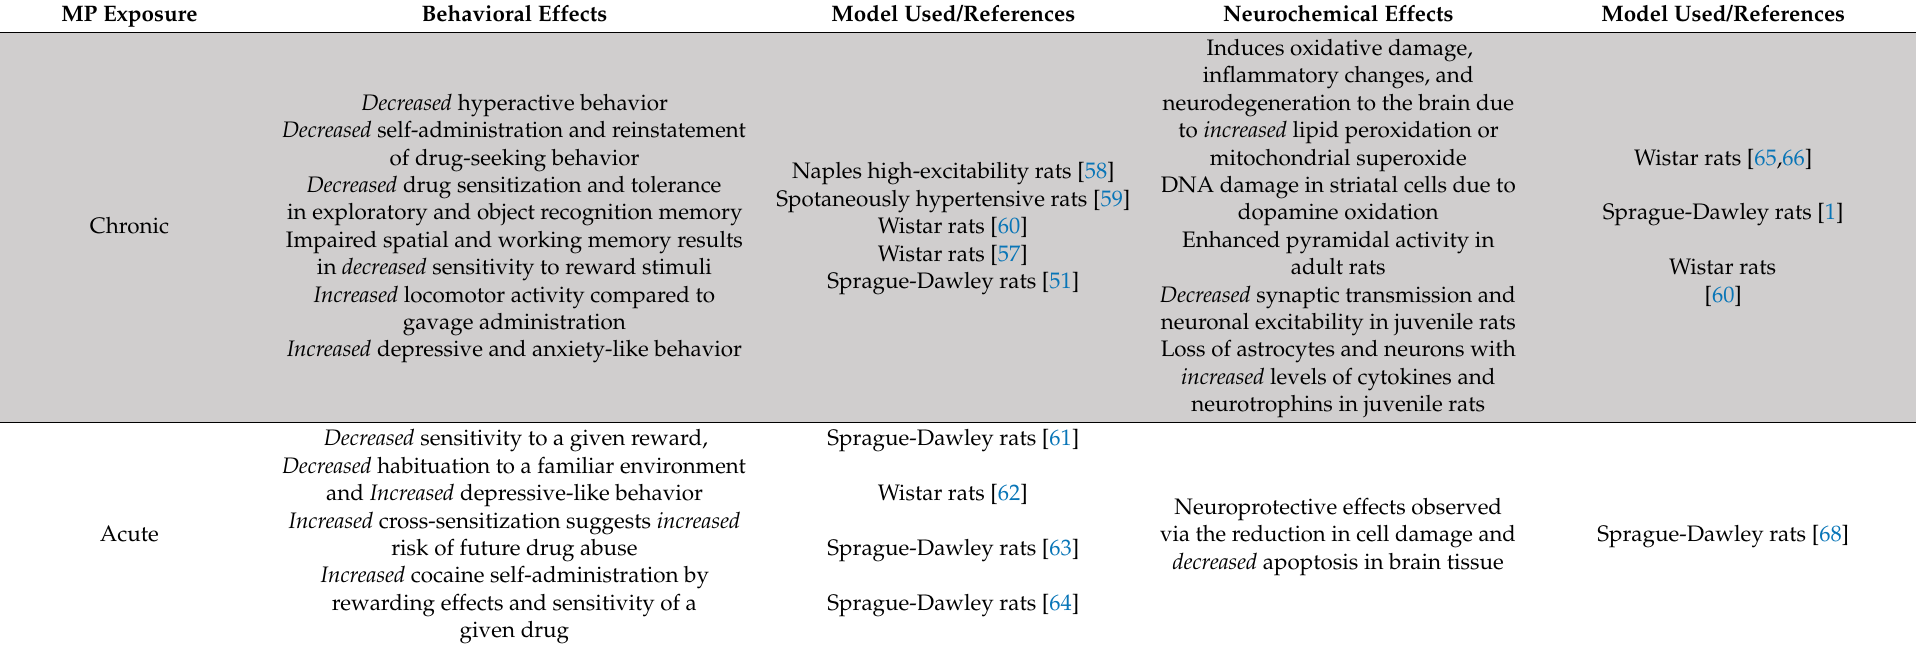
Table 1. Summary of behavioral and neurochemical effects on injected